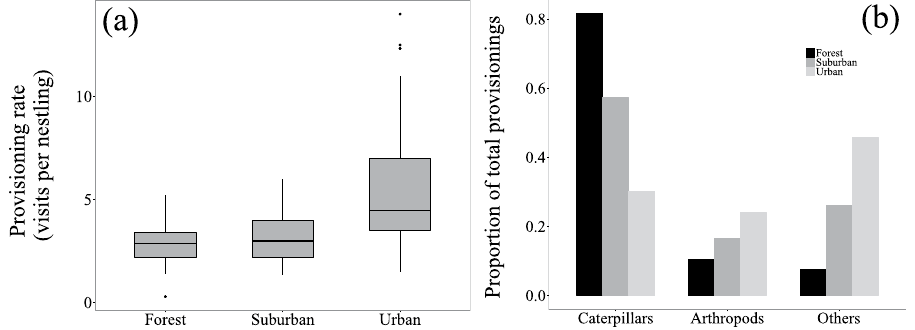
Figure 2. Provisioning of nestlings. ( a ) Provisioning rates of parents to offspring across the three study sites per 30 min. Rates are expressed per nestling, that is, number of visits per brood/brood size. ( b ) Proportions of total provisioned items for different groups of dietary components at each of the three study sites. Data for both panels were obtained from a total of 2 h of video footage combined from 4 different 30-min intervals recorded on the same day.